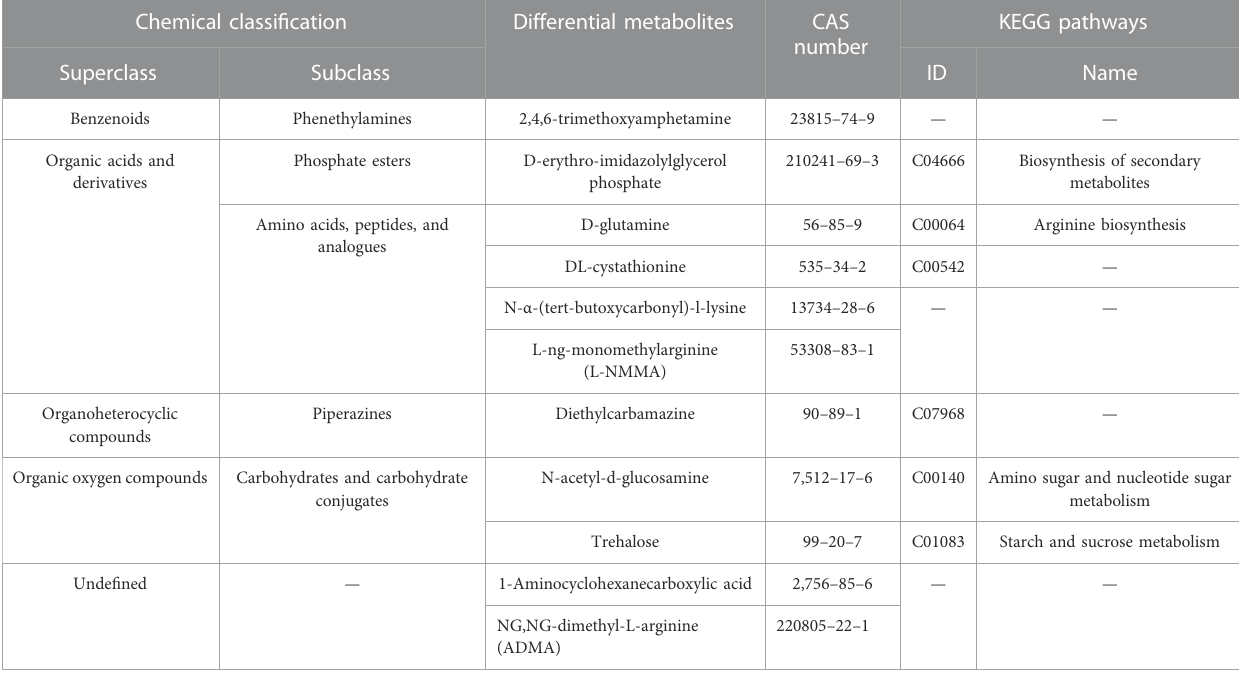
TABLE 1 Chemical classi fi cation of intestinal differential metabolites in Clanis bilineata tsingtauica larvae induced by diapause